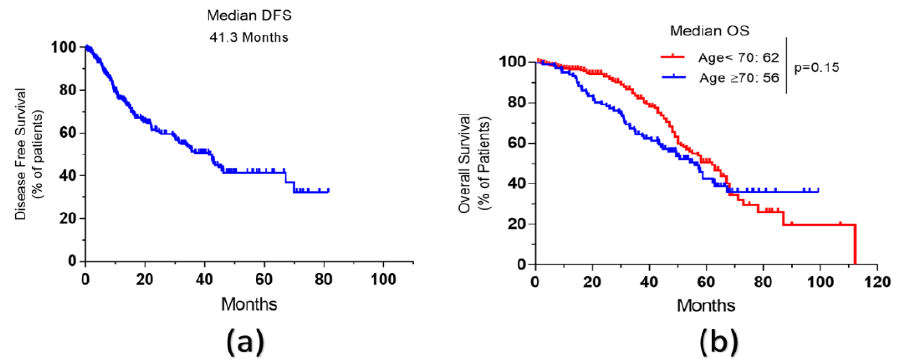
Figure 1. Survival Curves of older patients with resectable CRLM. ( a ): Disease-free survival (DFS). ( b ): Overall survival (OS) of older patients compared to that of younger patients. Patients with left-sided colon cancer had a better overall survival compared to right- sided disease, with a median OS of 67.2 months compared to 46.8 months respectively, HR = 0.69; p = 0.017 (Figure 2a).